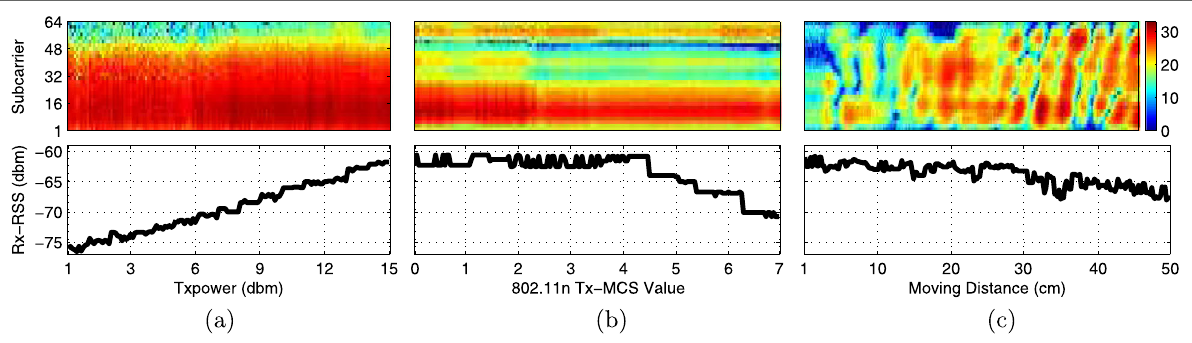
Fig. 1 a The CSI amplitude remains unchanged when the Tx-power increases, while the Rx-RSS increases by 13 dBm. b When the MCS value 1 increases, the CSI remains unchanged, but the Rx-RSS decreases by 10 dBm. c When the client is moving, the CSI shows rapid spatial de-correlation, while the RSS changes slowly along the